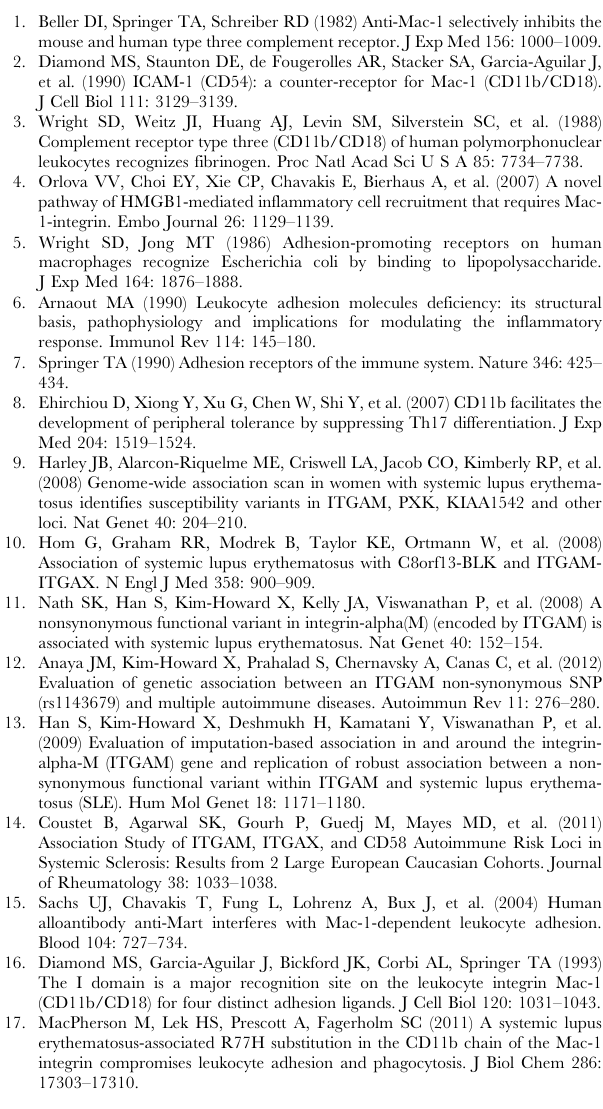
Figure S4 Cytokine response. Modulation of TLR7/8- induced cytokine release by iC3b-gRBC. Monocytes were fed with iC3b-gRBC or gRBC one hour prior to R848